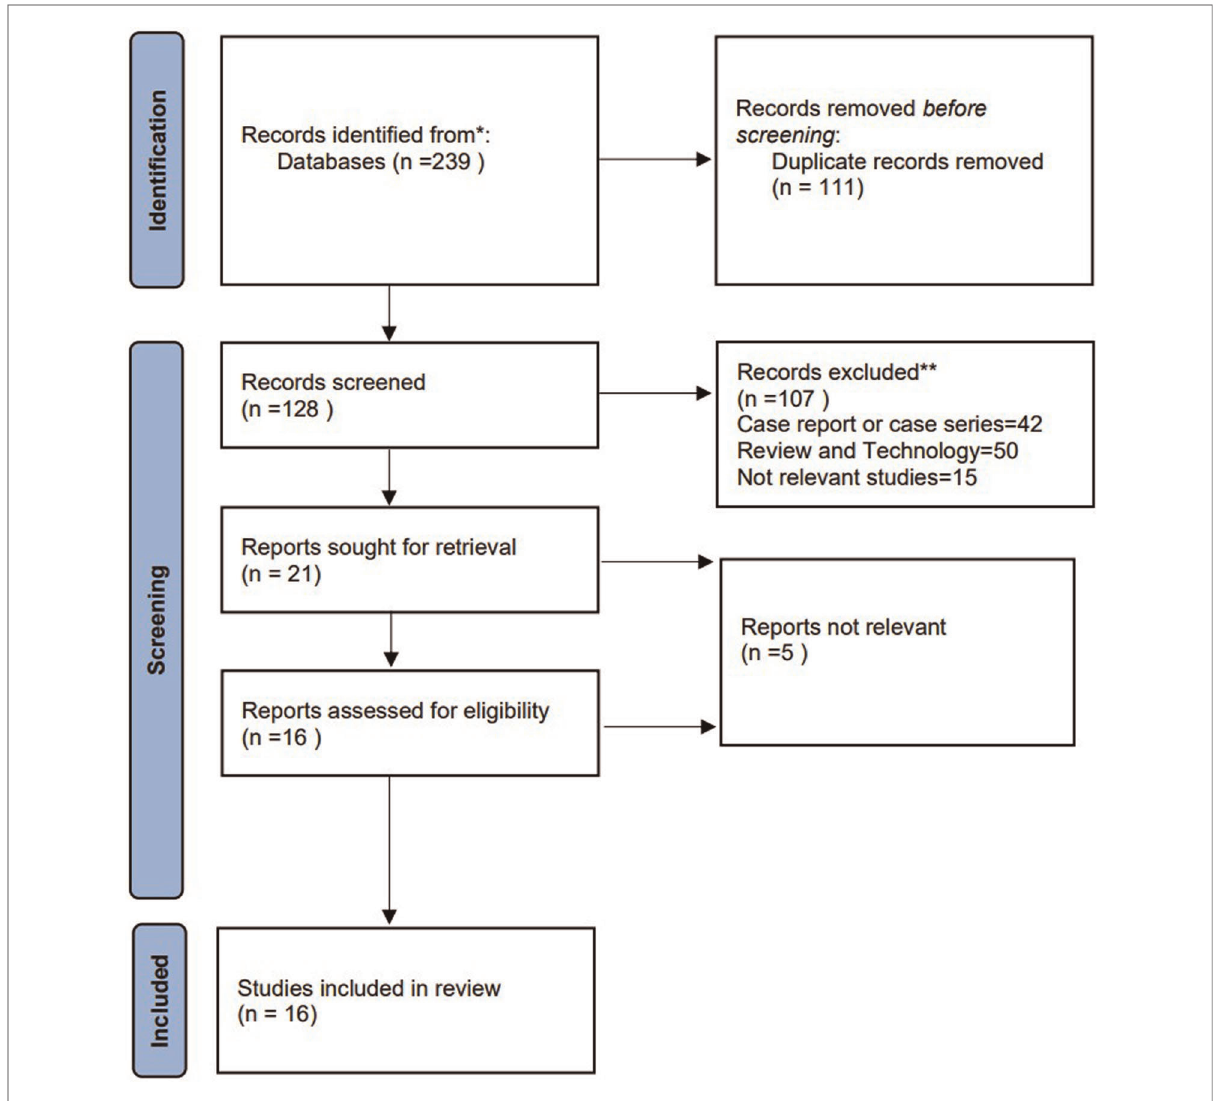
FIGURE 1 Flow chart of study